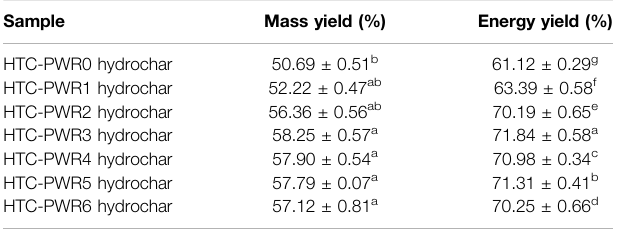
TABLE 1 | The mass and energy yields of wheat straw hydrochar after process water recirculation. Sample Mass yield (%)